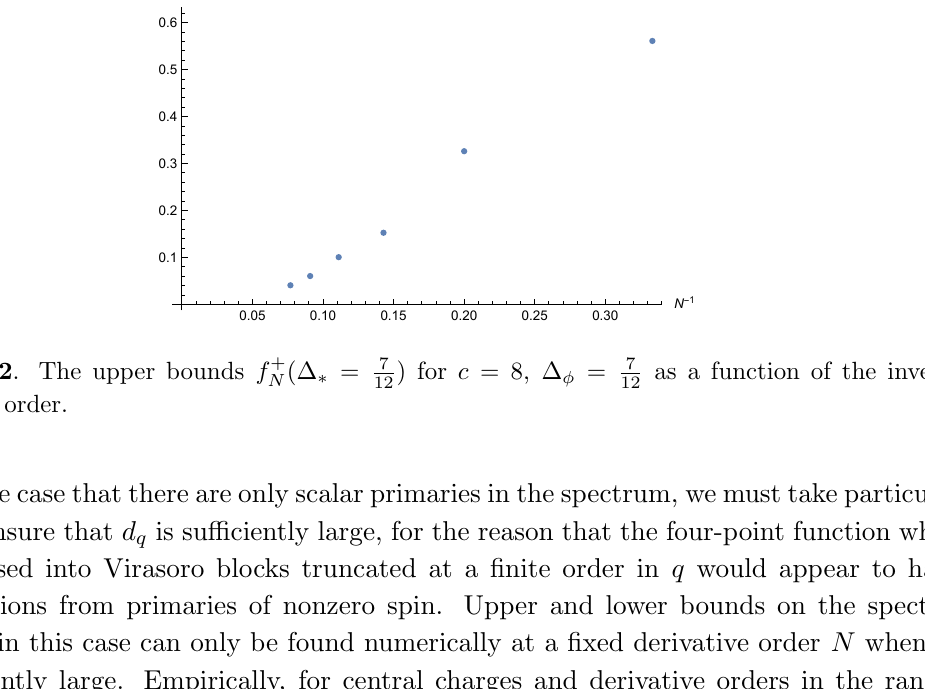
((cid:1) (cid:3) = 7 ) for c = 8, (cid:1) (cid:30) = 7 N 12